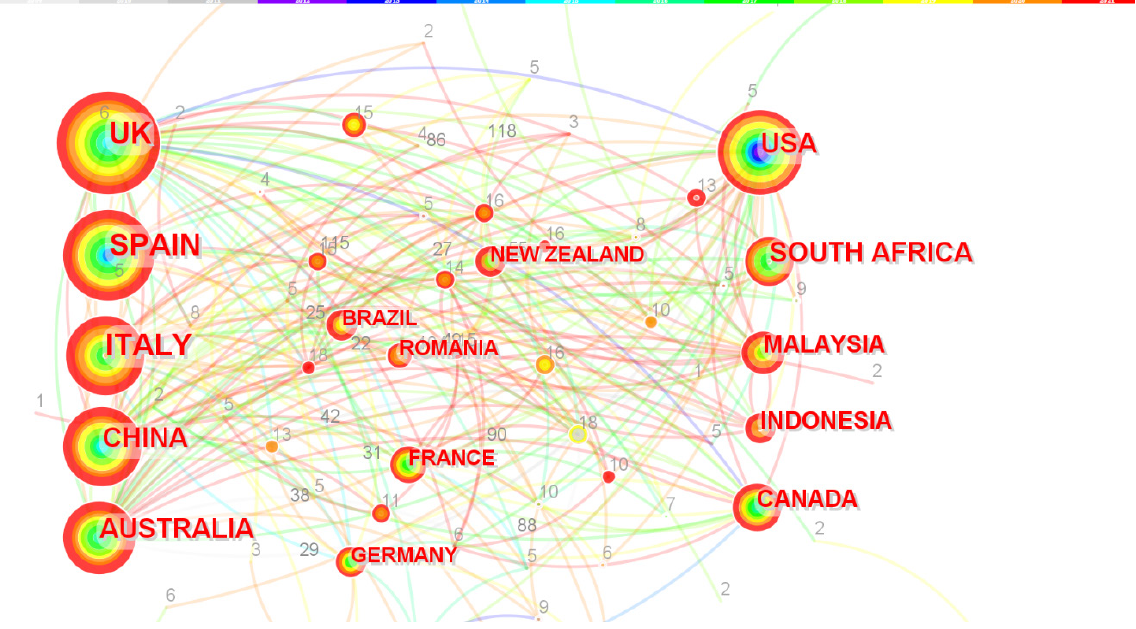
Figure 3. Number of articles in each